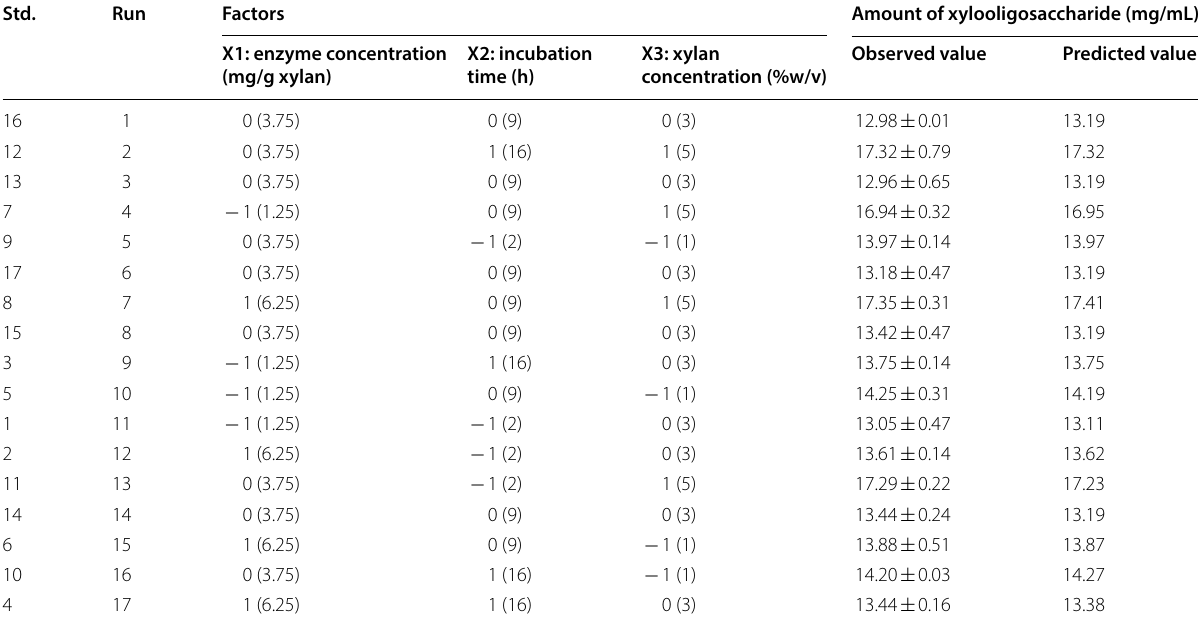
Table 4 The variable factors and predicted and observed xylooligosaccharide yield Std.